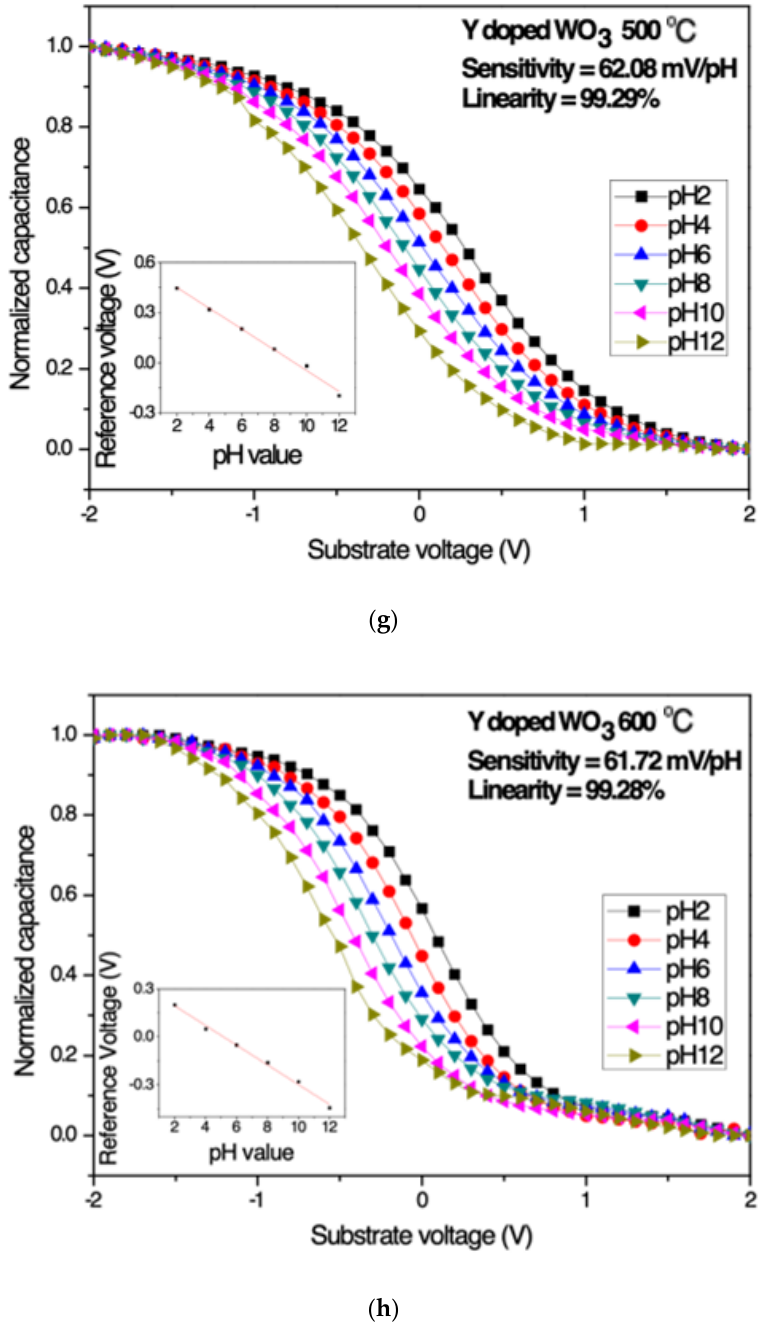
Figure 5. Sensitivity and linearity of the WO 3 sensing membrane based on EIS structure annealing in O 2 ambient with different temperatures ( a ) as-dep, ( b ) 400 °C, ( c ) 500 °C, ( d ) 600 °C. The sensitivity and linearity of the Y-doped WO 3 sensing membrane based on EIS structure annealing in O 2 ambient with different temperatures ( e ) as-deposited, ( f ) 400 °C, ( g ) 500 °C, and ( h ) 600 °C.